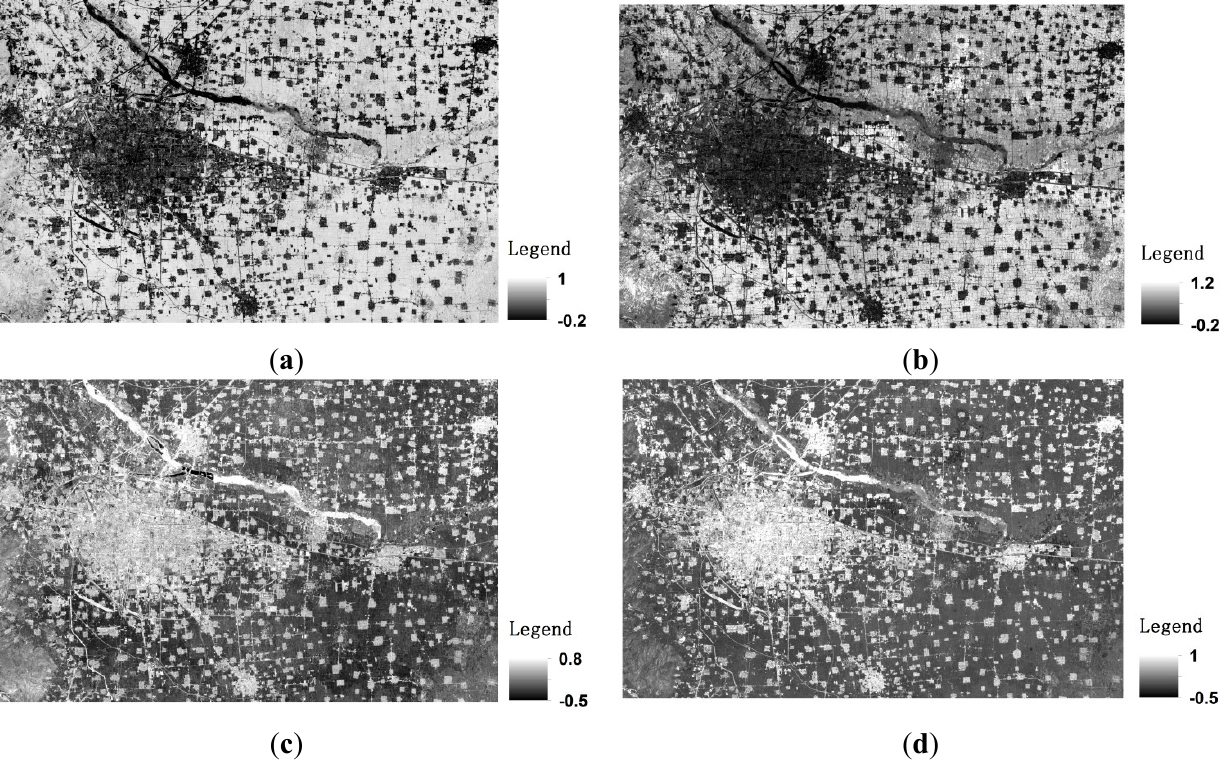
Figure 6. Spectral indices in the study area derived from Landsat TM image on 15 August 2010, ( a ) Normalized Difference Vegetation Index (NDVI); ( b ) Universal Pattern Decomposition (VIUPD); ( c ) Normalized Difference Built-up Index (NDBI) and ( d ) Biophysical Composition Index